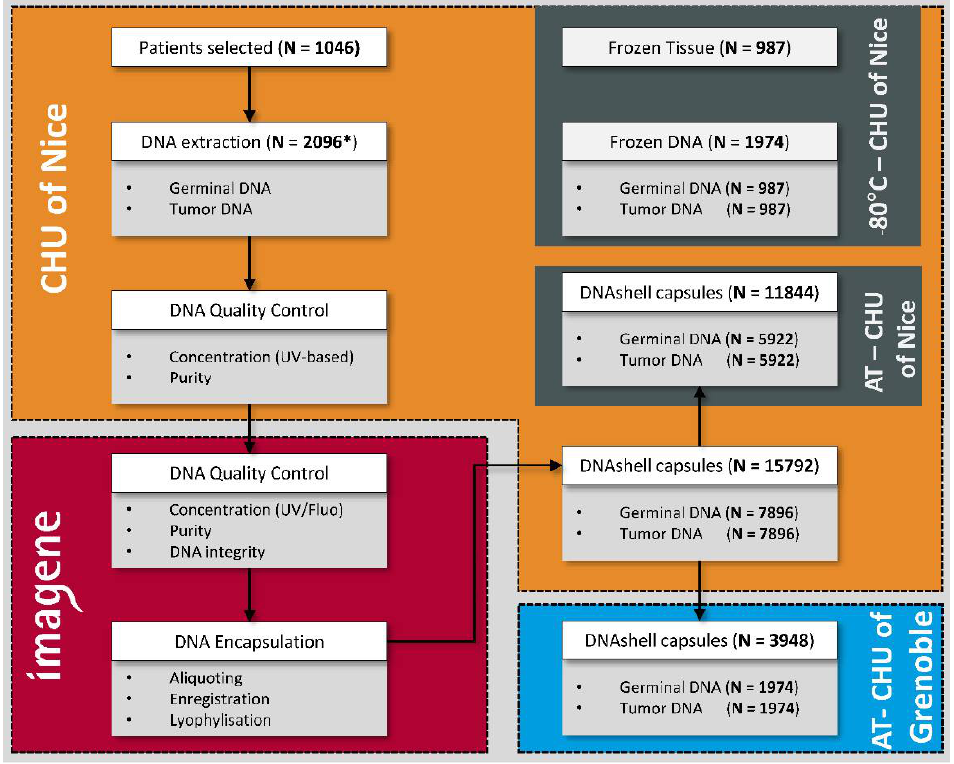
Figure 3 : Workflow of the selected samples for duplication and storage in different sites. * For each patient, two samples have been selected: one tumor sample and one healthy tissue sample.